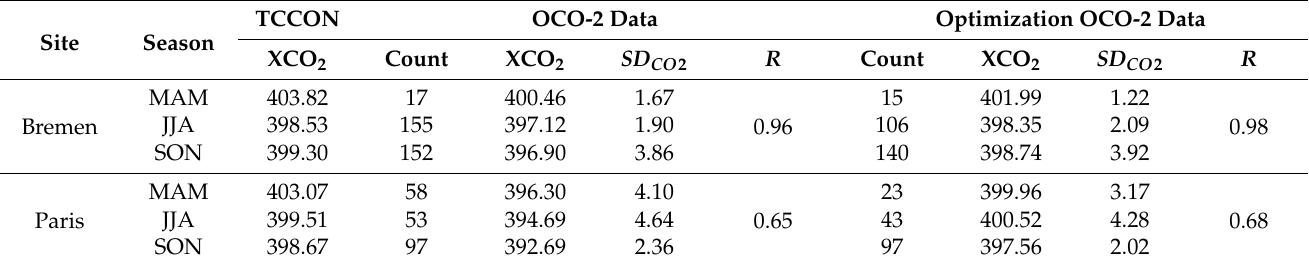
Table 7. Summary of the XCO 2 among TCCON, OCO-2, and optimization results for Bremen and Paris during 2015–2016. SD CO 2 is the standard deviation of XCO 2 .